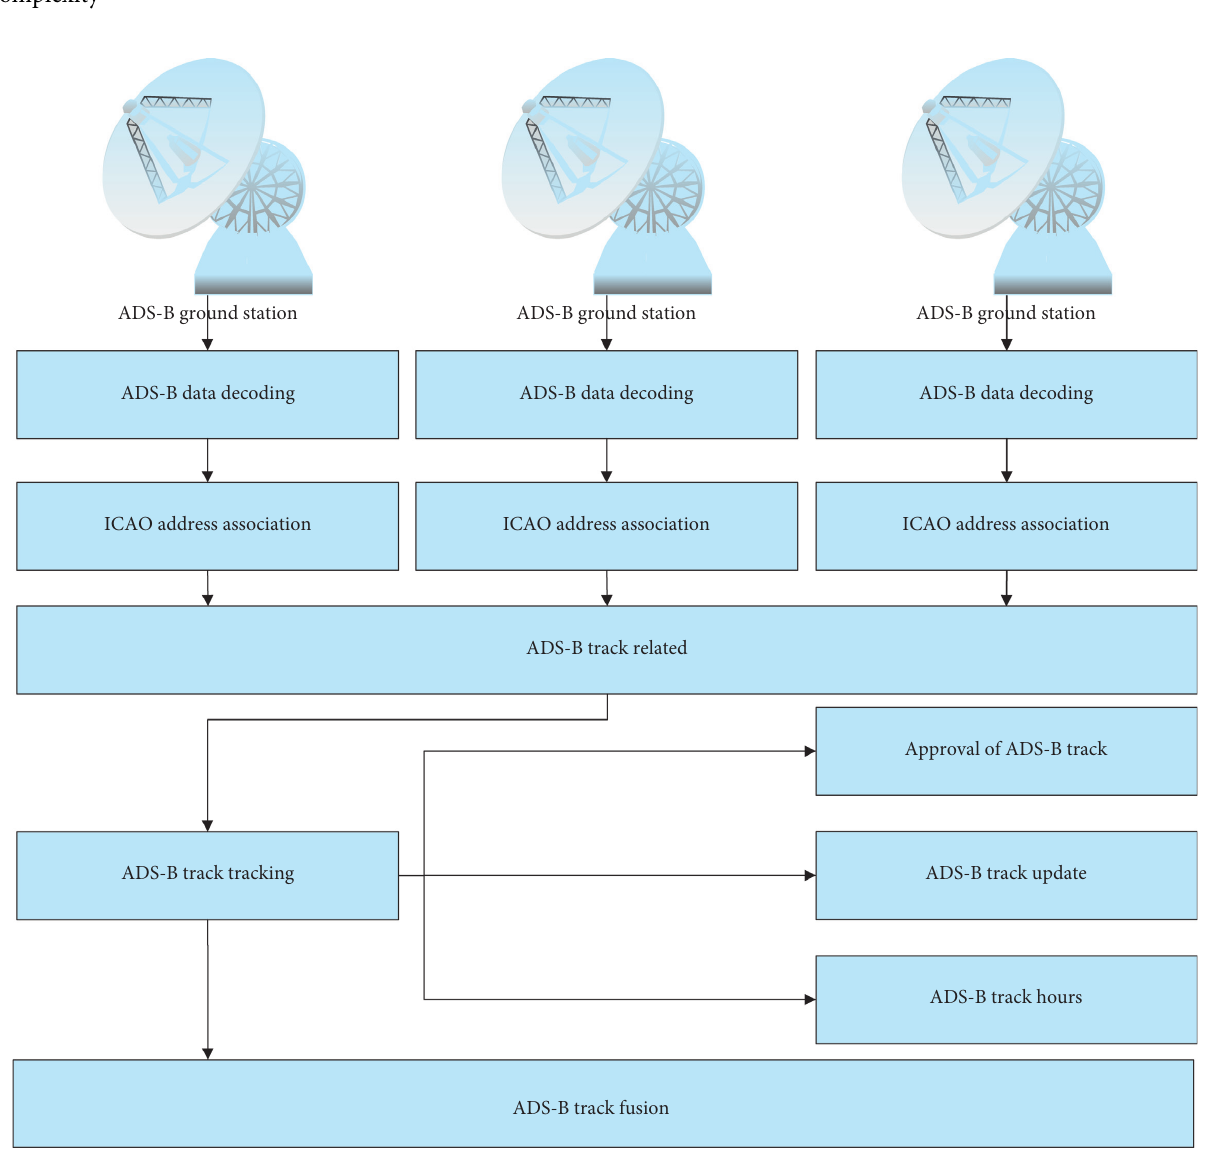
Figure 3: View of ADS-B data processing